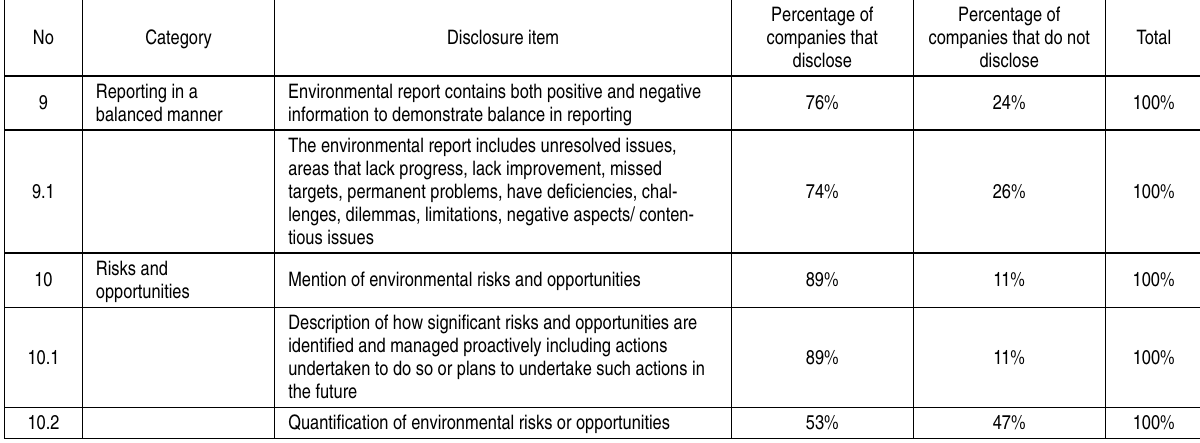
Table 5. Disclosure of environmental information in a balanced manner, as well as risks and